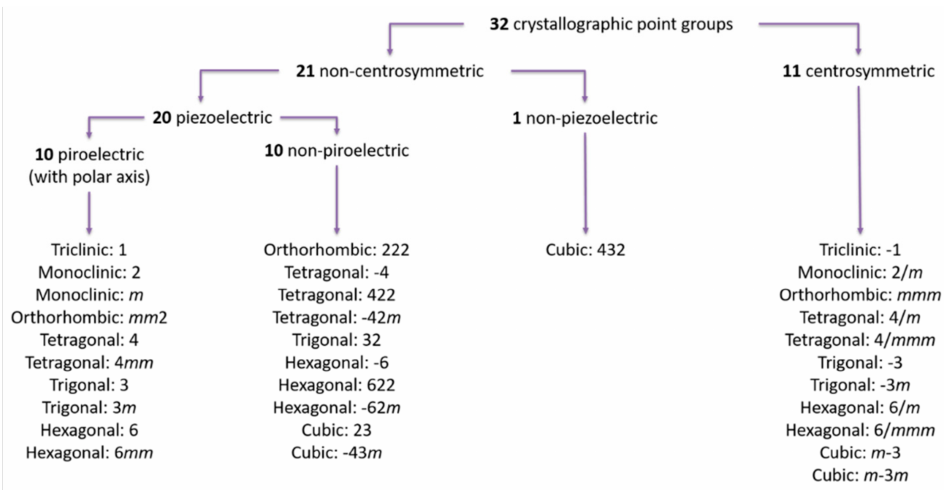
Figure 4. Correlation between crystallographic points (i.e., geometric crystal classes) and electric responses of different crystal